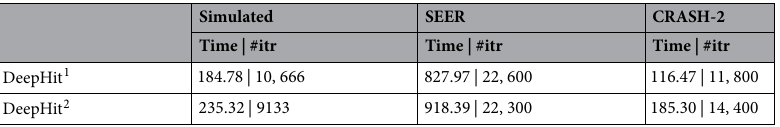
Table 4. Average time (in seconds) and number of iterations needed for training DeepHit 1 and DeepHit 2 per dataset. Performance on validation data was used as the stopping